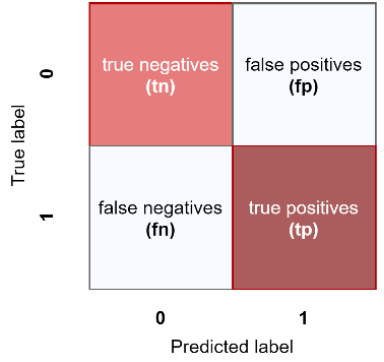
Figure 1. Confusion matrix for binary classification.